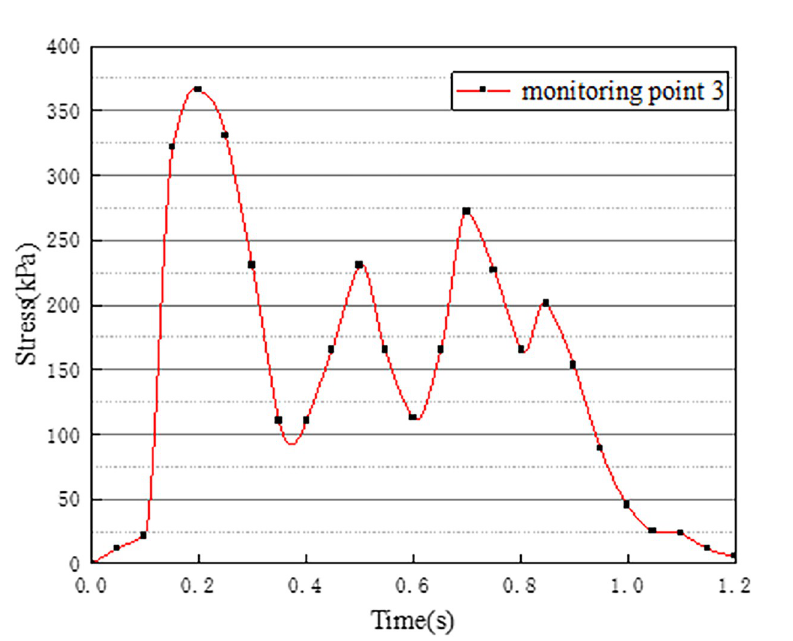
Fig 5. Stress time history curve of monitoring point 3.